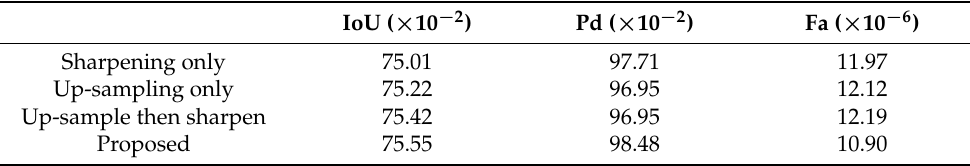
Figure 16. Comparison of ablation study results, where targets are shown in the red circle. 5. Conclusions In this paper, we propose an algorithm for infrared small-target detection based on small-target enhancement. Unlike conventional and deep learning-based algorithms, we